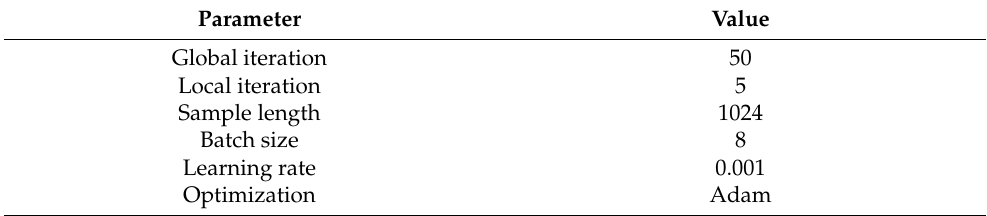
Table 4. Experimental setup